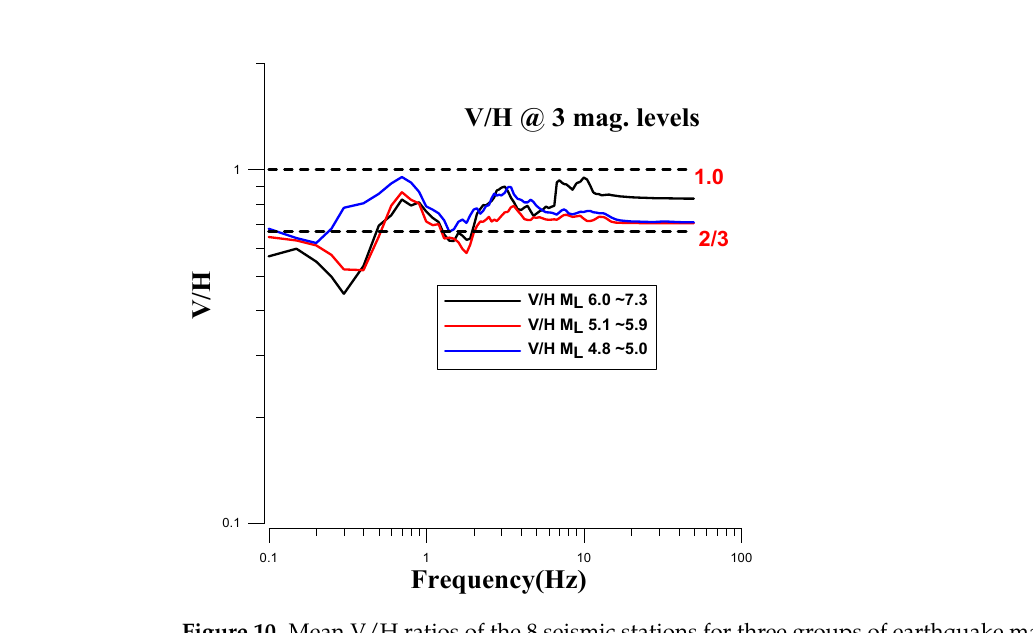
Figure 10. Mean V/H ratios of the 8 seismic stations for three groups of earthquake magnitude: M L 6.0–7.3 (black solid), 5.3–5.8 (red solid), and 4.6–5.0 (blue solid), respectively. The x -axis represents frequency and the y -axis the V/H ratios.